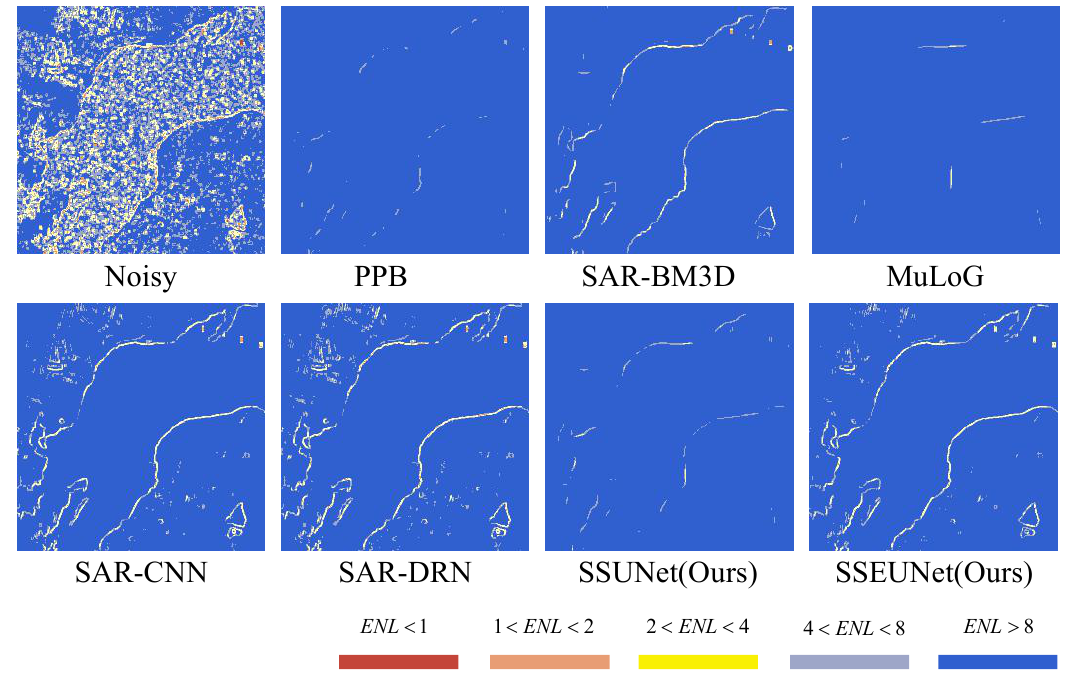
Figure 10. ENL maps of different despeckling methods on R10.